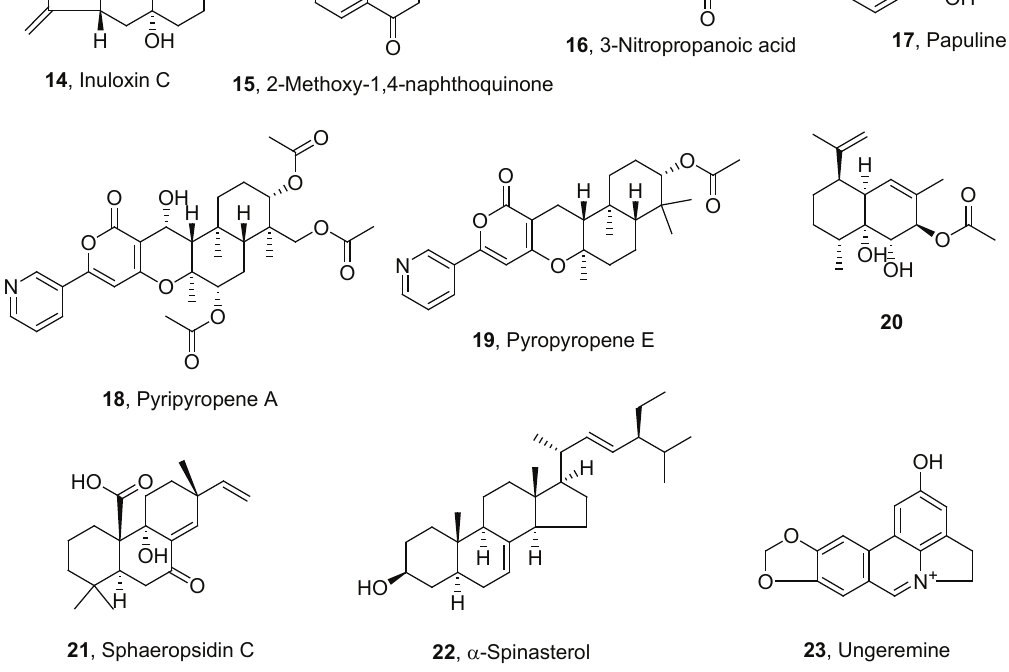
Figure 1: Structures of bacterial, fungal and plant metabolites assayed against Ae.